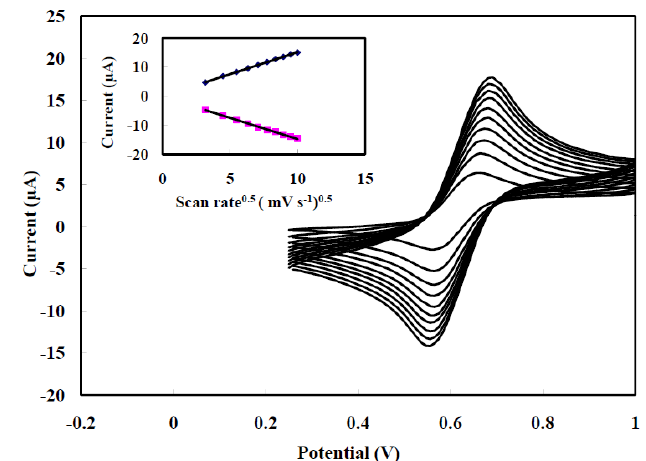
Figure 2. Cyclic voltammogram of 0.10 mM Cu-complex in ACN and 0.050 M n-Bu different scan rate between 0.2 and 1 V, from inner to outer 10, 20, 30, 40, 50, 60, 70, 80, 90 and 100 mV s -1 . Inset: plot of anodic and cathodic peak current vs . square root of scan